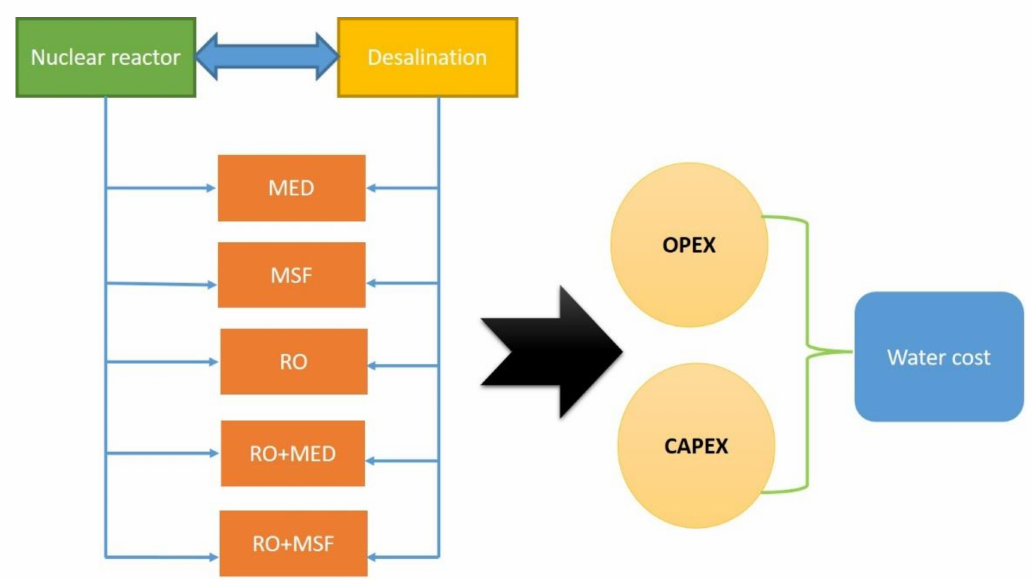
Figure 5. Flow diagram of the coupled nuclear desalination systems with various